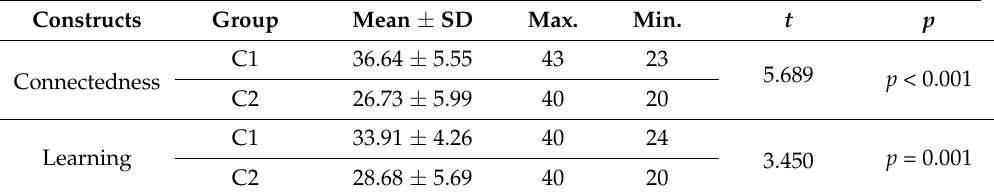
Table 5. Impact of PBL on the Sense of Connectedness and Class Learning.